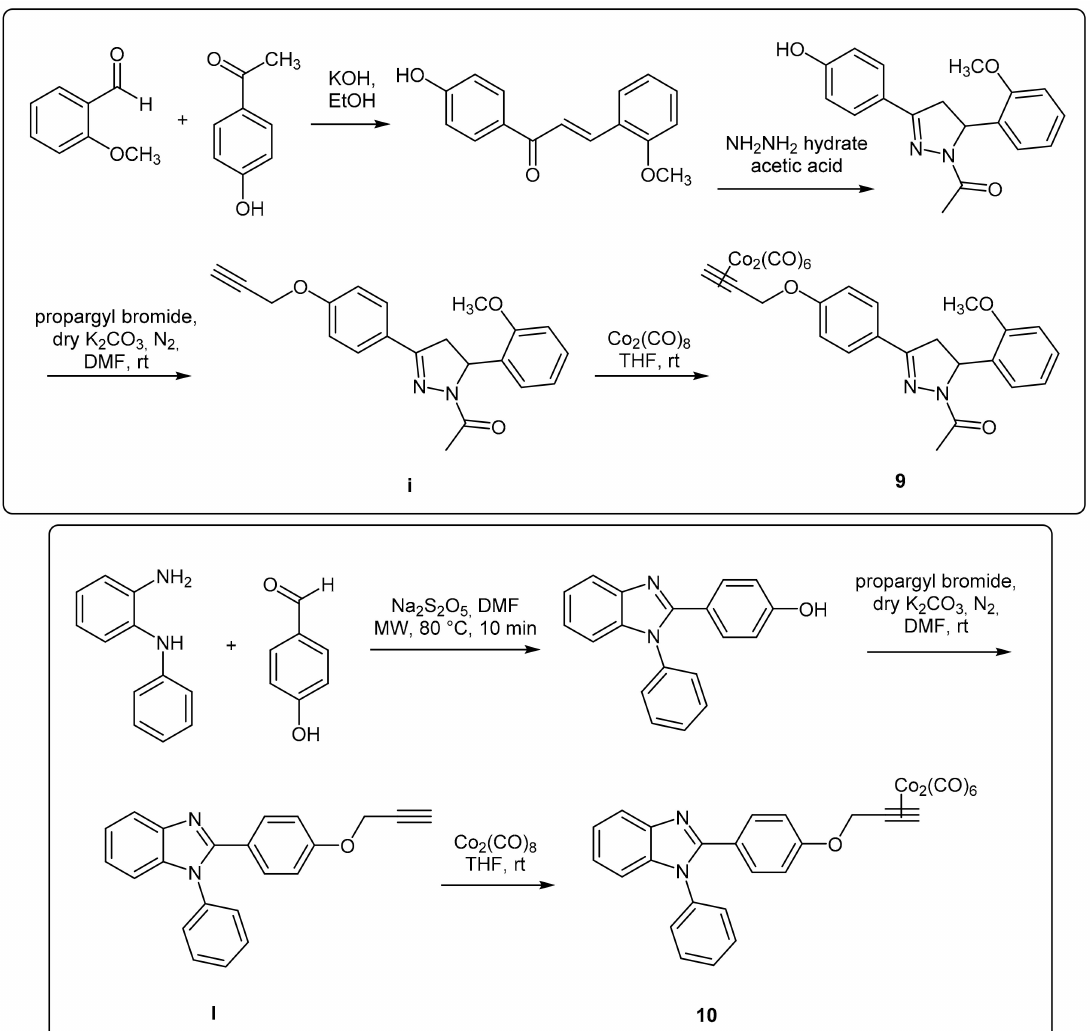
Figure 2. Pyrazoline- and benzimidazole-based